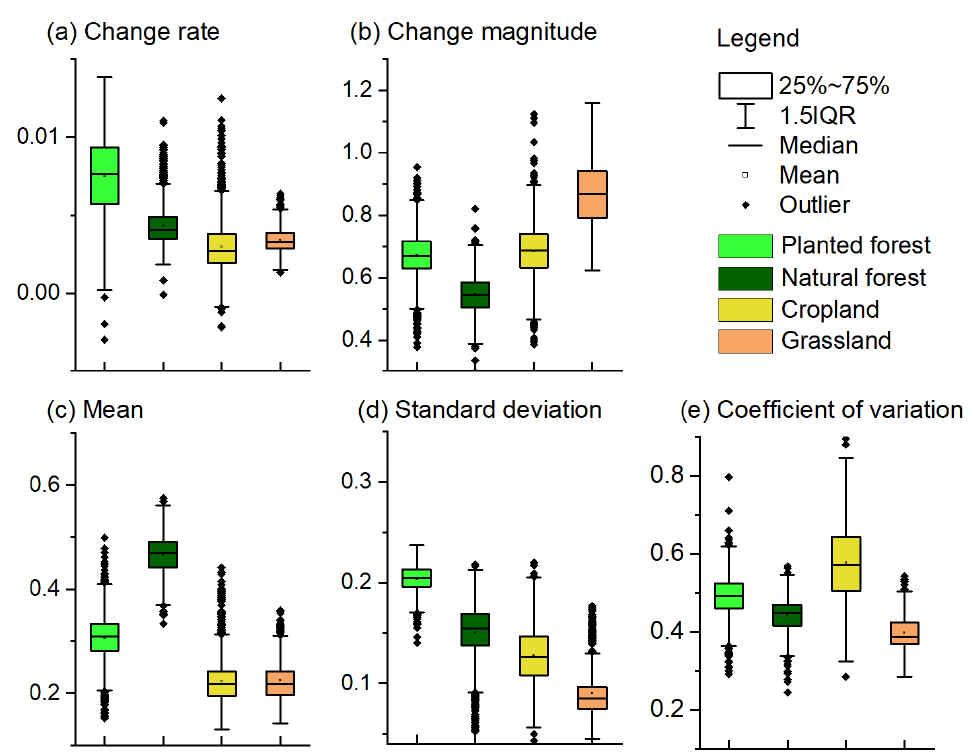
Figure 4. Box plot of vegetation reference samples of the long-term time series of the NDVI: ( a ) change rate, ( b ) change magnitude, ( c ) mean ( µ ), ( d ) standard deviation ( σ ), and ( e ) coefficient of variation ( µ / σ ) of different vegetation types (planted forest, natural forest, cropland and grassland).